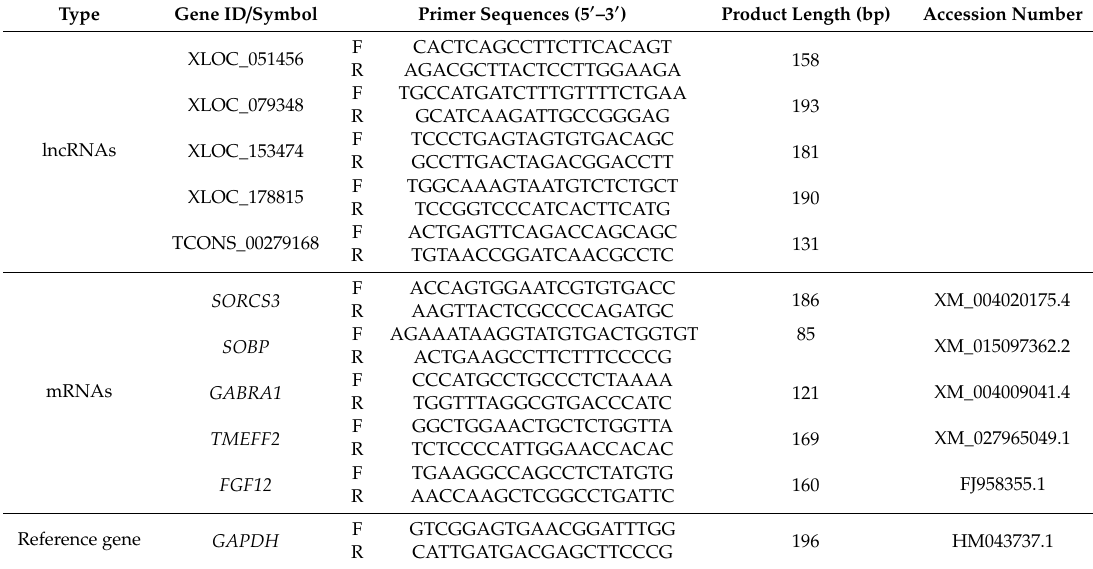
Table 1. The information of